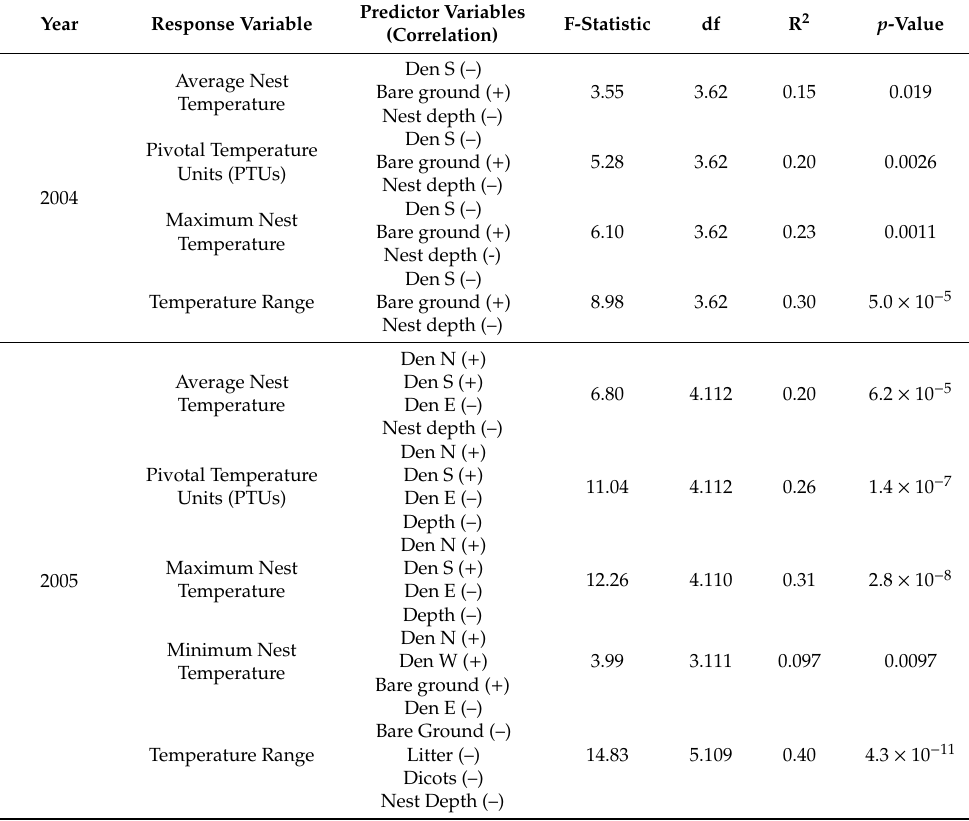
Table 3. Results from bidirectional stepwise multiple linear regression model selection and subsequent multiple linear regressions to determine which nest microhabitat and depth variables correlated with nest temperature measurements during the temperature-sensitive period in diamondback terrapins ( Malaclemys terrapin